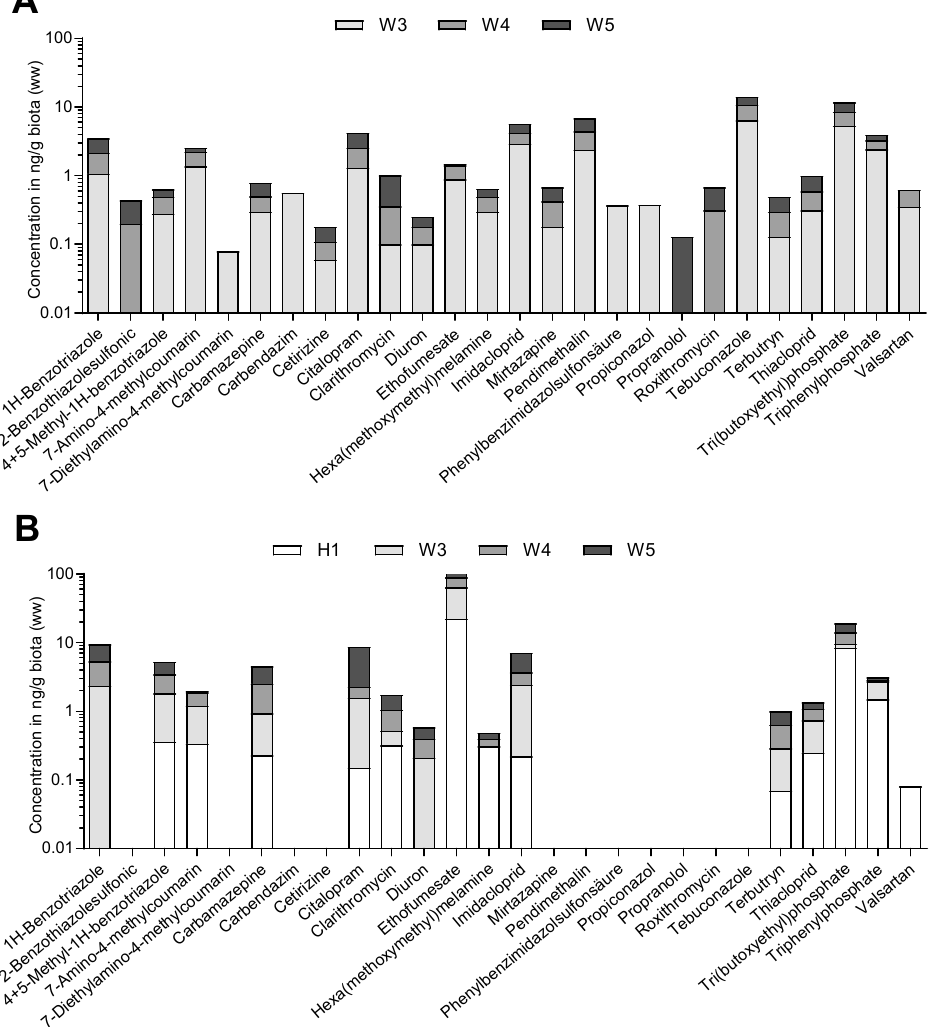
Figure 3. Results of biota analyses for sampling sites at which a sufficient amount of gammarids were obtained. Concentrations of quantified substances are shown for the sampling performed in February 2016 ( A ) and May 2017 ( B ).